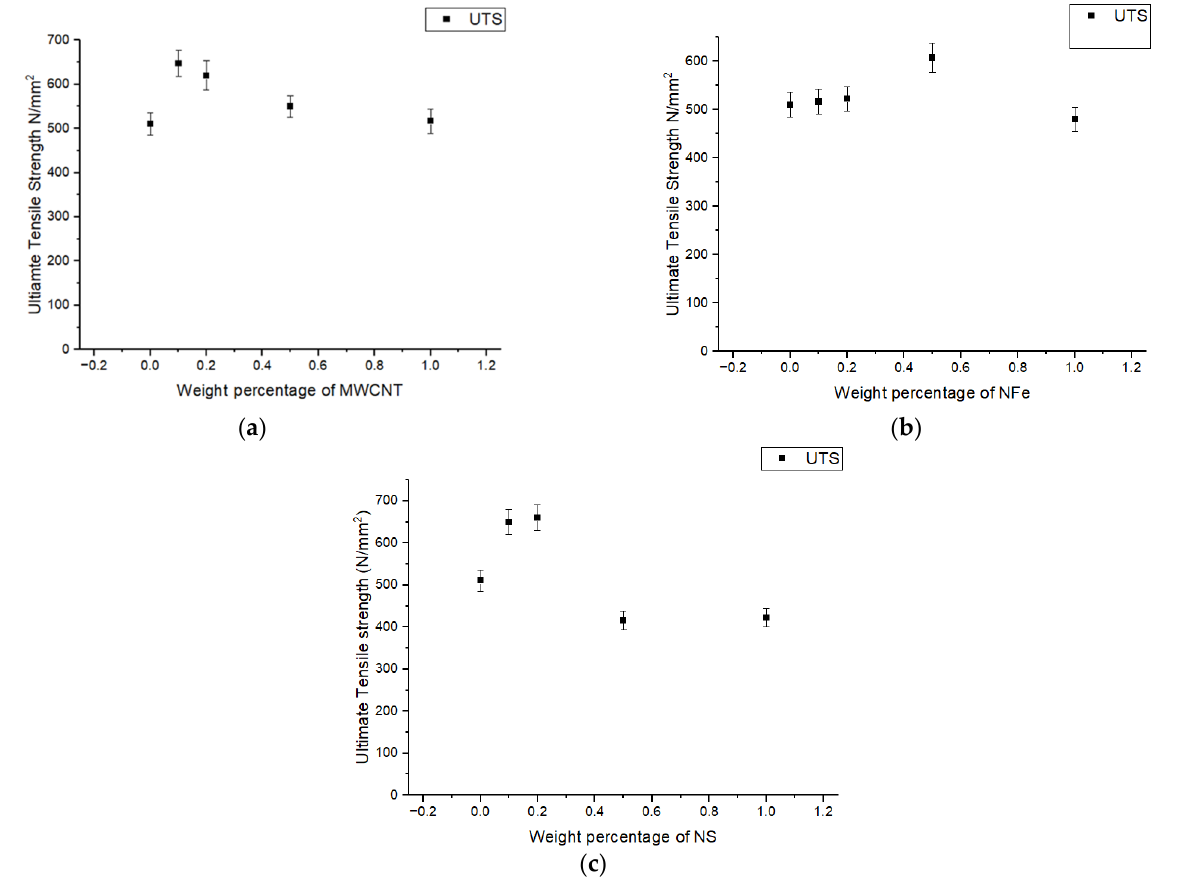
Figure 4. Variation in ultimate tensile strength of modified GFRP samples with different weight percentages of ( a ) MWCNTs, ( b ) NFe, and ( c ) NS.